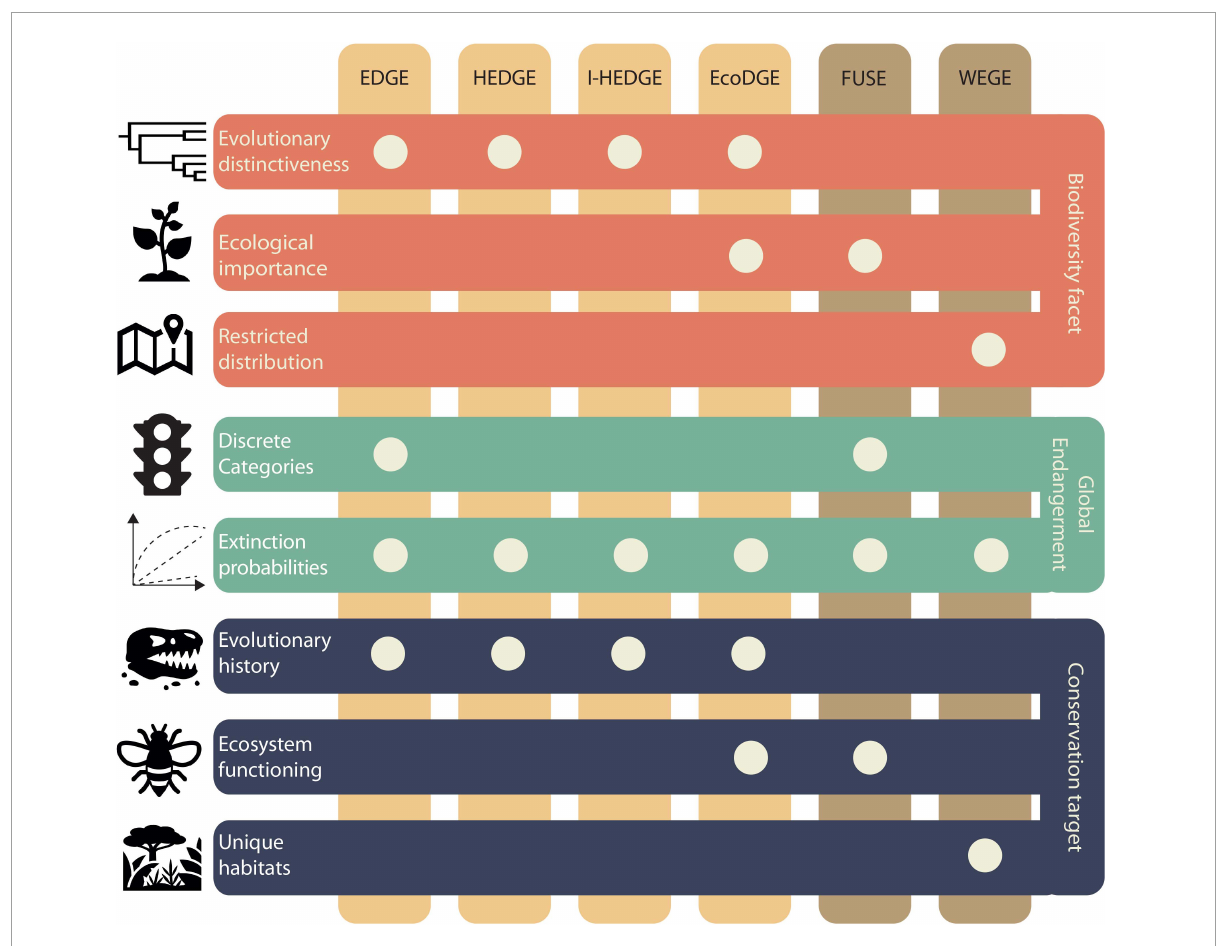
FIGURE2 International Union for Conservation of Nature (IUCN)-based conservation prioritisation metrics. Orange horizontal bars show the prioritisation criteria that are combined with global endangerment (GE). Green bars show how GE is used in each metric ( Table 1 ). Blue bars show their conservation prioritisation